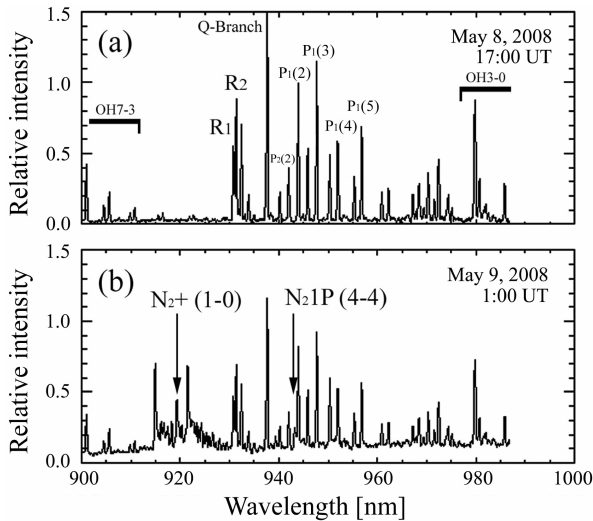
Figure 1. Sample spectrum of the OH 8-4 band obtained with a 1-minute exposure. (a) Spectra correspond to quiet auroral conditions, while (b) spectra correspond to active auroral conditions.